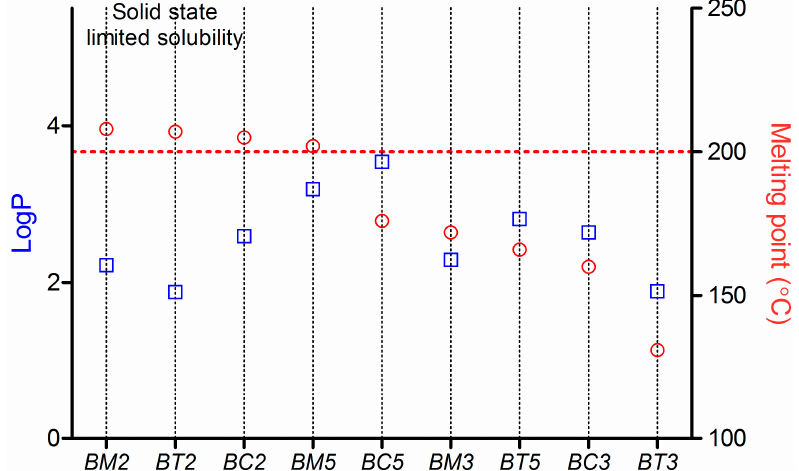
Figure 5. Analysis of the tested compounds from the general solubility equation (GSE) point of